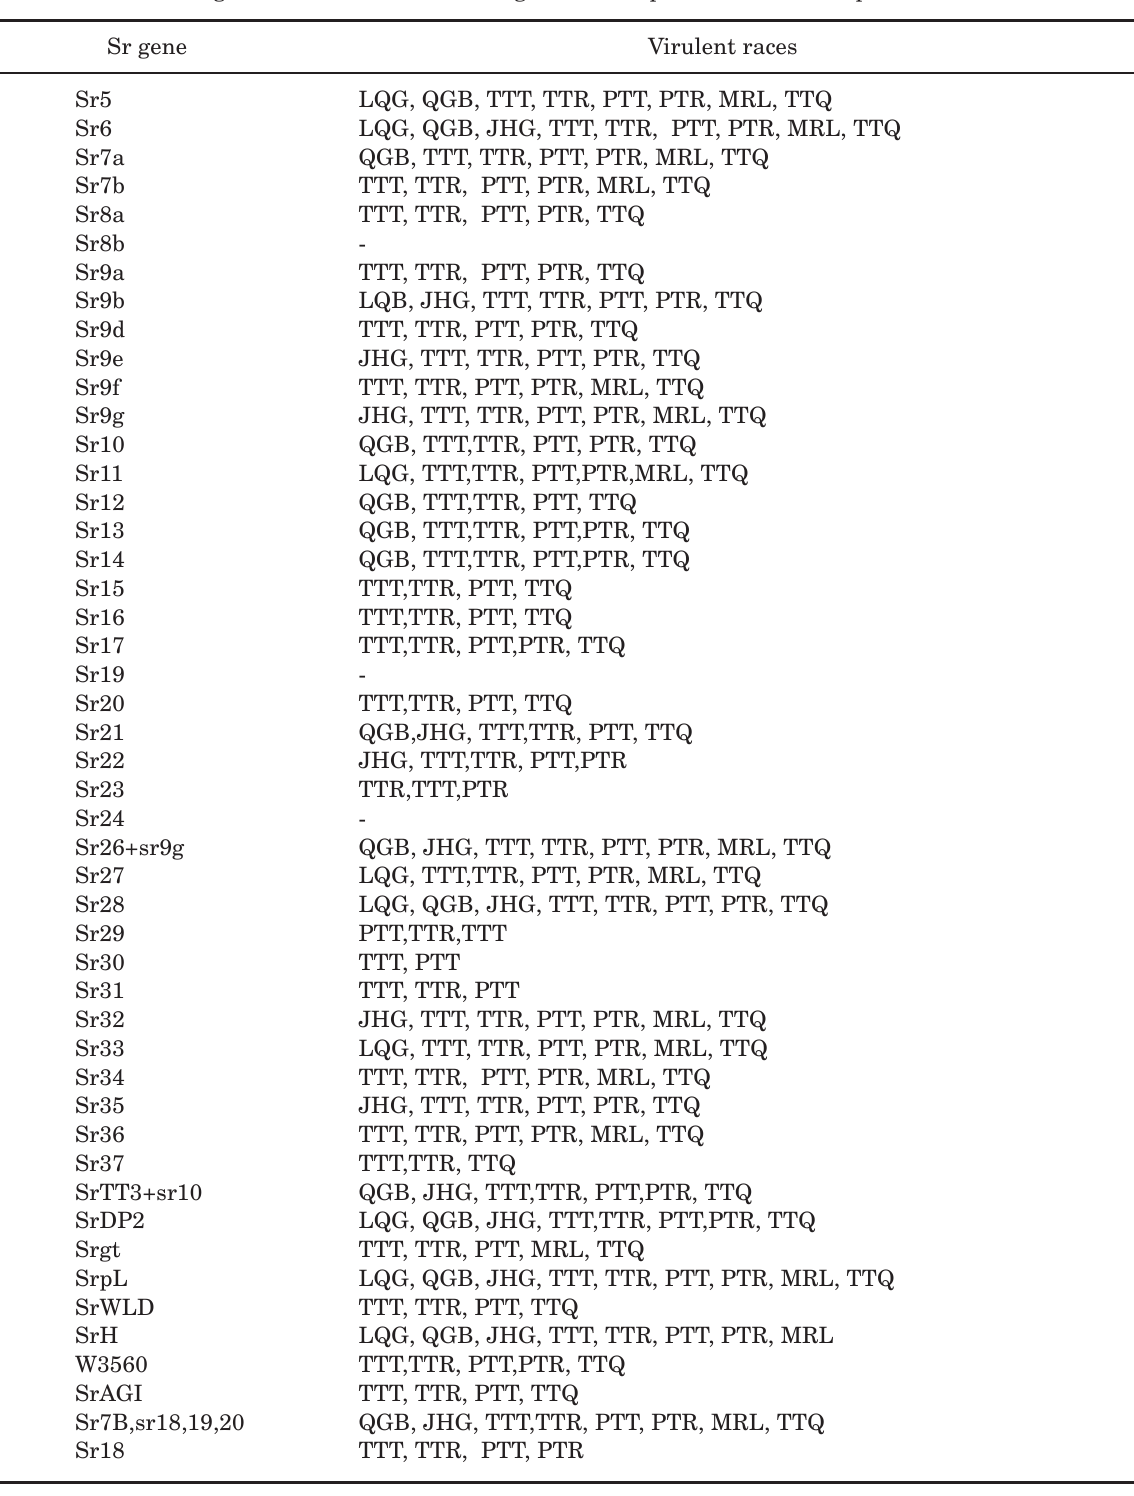
Table 6. Reaction of Sr genes to different races of P. graminis f. sp. tritici from Ethiopia. Sr gene Virulent